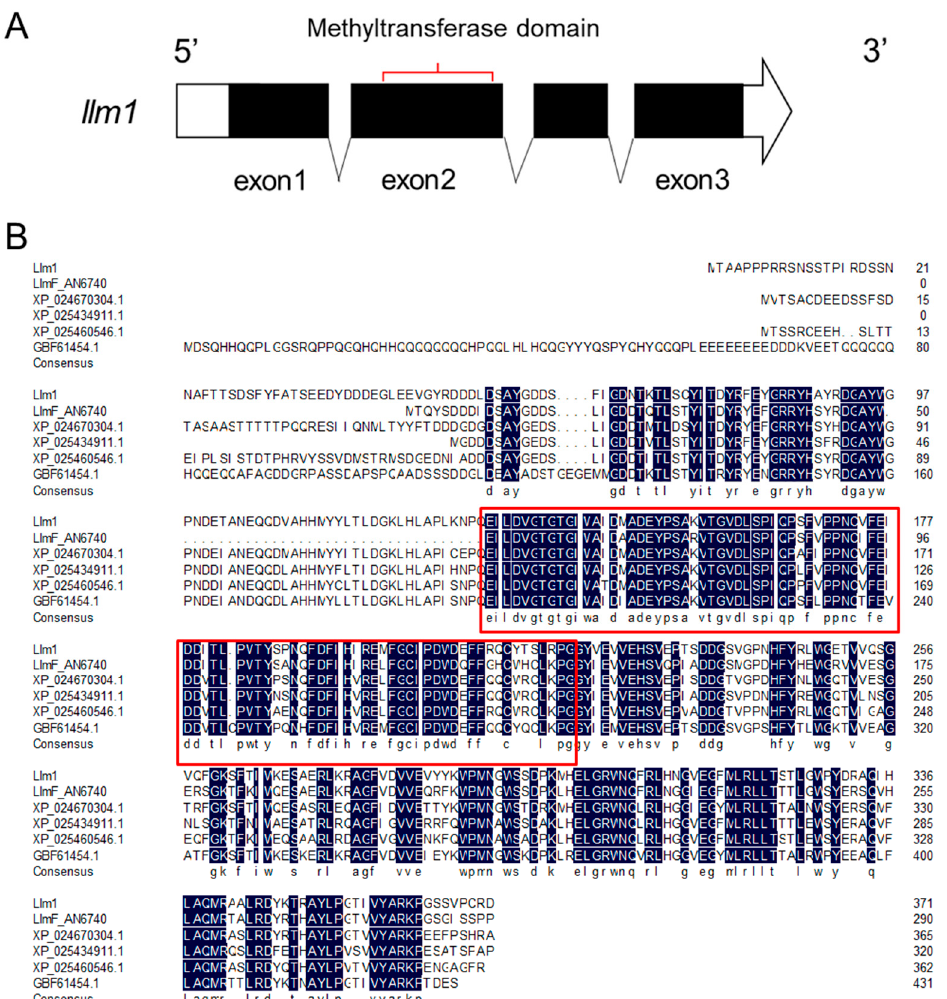
Figure 1. Bioinformatics analysis of llm1 . ( A ) Structure diagram of llm1 gene. ( B ) Alignment of the amino acid sequence of Llm1 with the sequences of A . nidulans (LlmF); A . candidus (XP_024670304.1); A . saccharolyticus (XP_025434911.1); A. niger (XP_025460546.1); and Trichophyton mentagrophytes (GBF61454.1). The navy boxes represent 100% conservatism and the red boxes indicate the location of the methyltransferase domain.